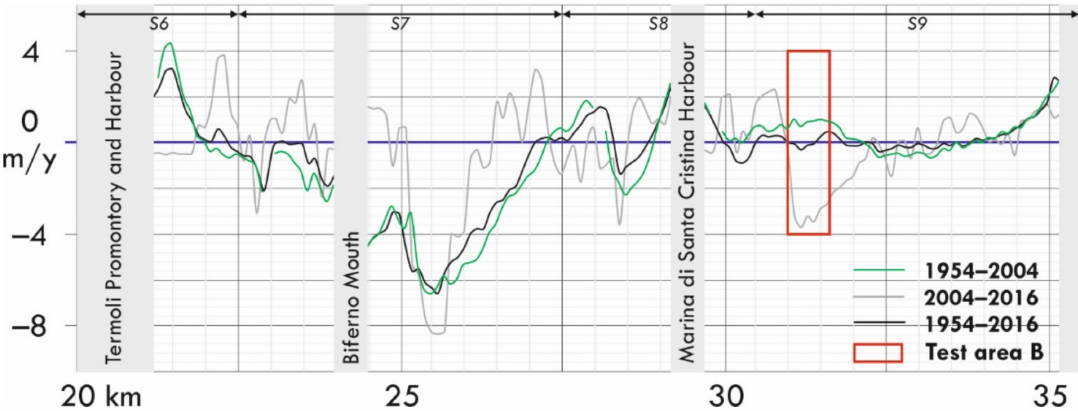
Figure 5. Long to mid-term annual shoreline changes along the southern Molise coast